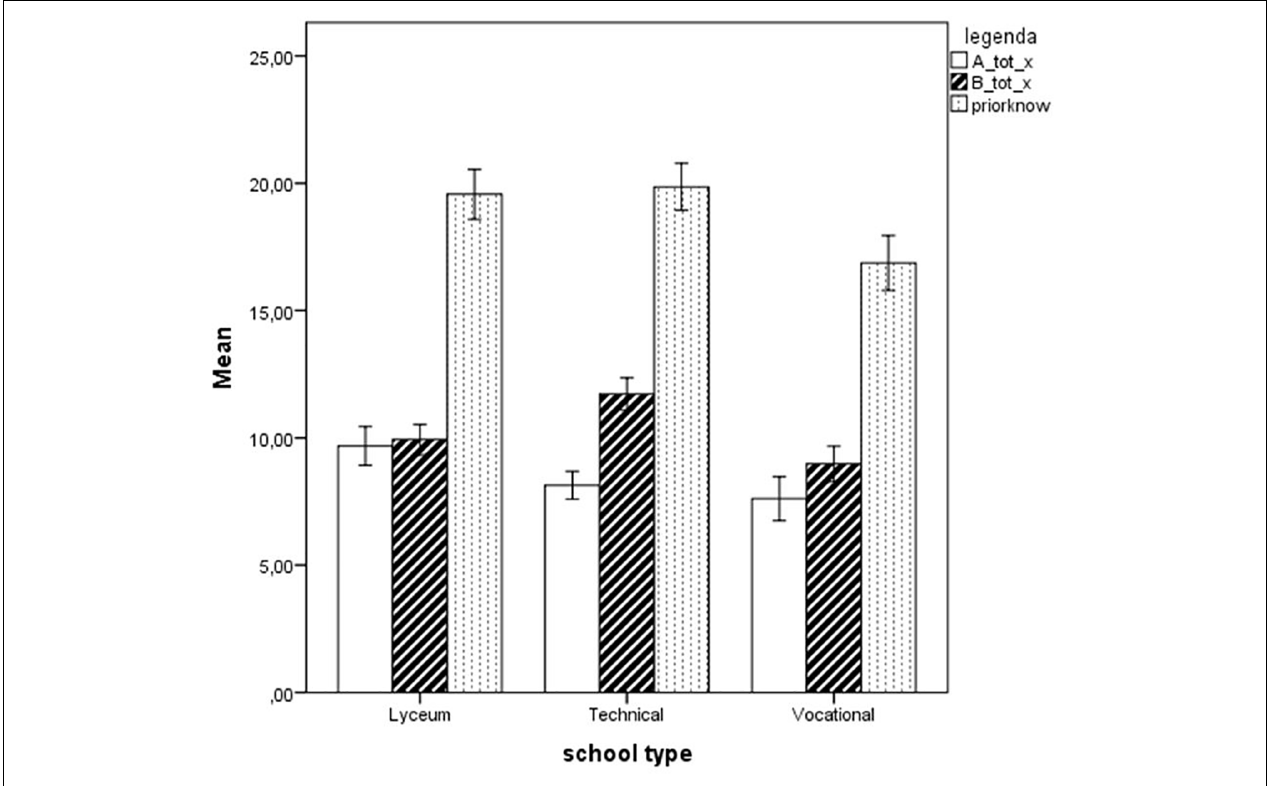
FIGURE 3 | Performance of students from the three different school types on the two topics A (music and brain) and B (electromagnetic waves and health), and total prior knowledge (the sum of the two). Error bars illustrate 95% Confidence Intervals for the Mean.